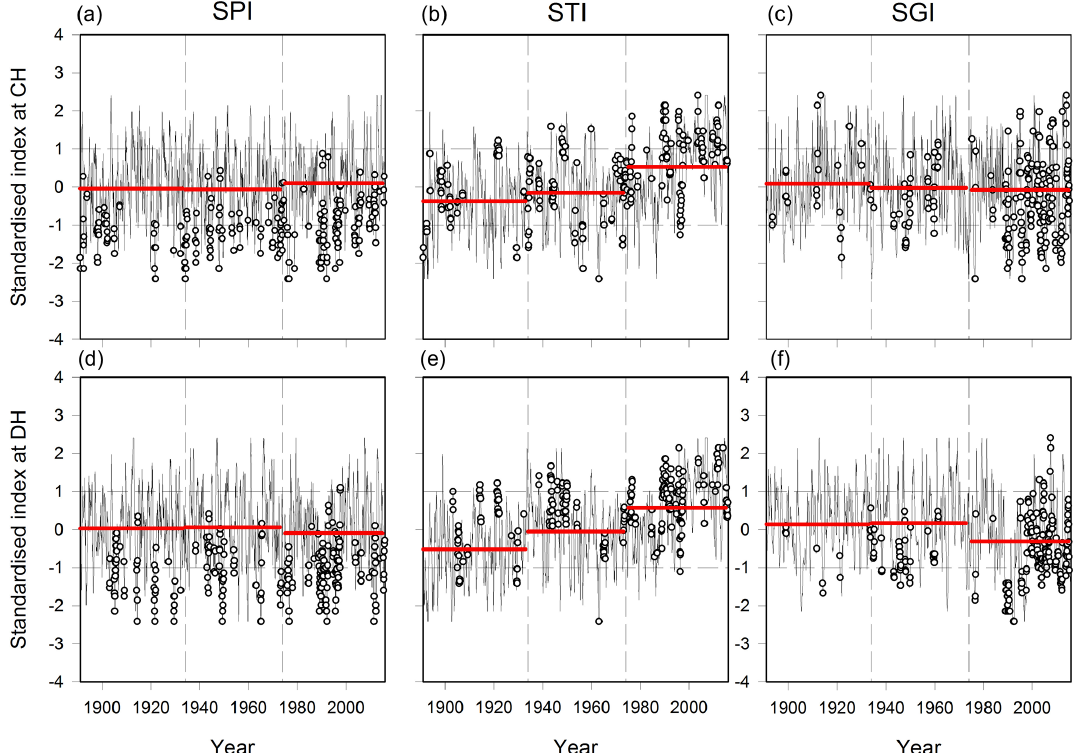
Figure 2. Changes in standardised indices of precipitation, temperature and groundwater level since 1891. Time series of SPI, STI and SGI for CH (a, b, c) and DH (d, e, f) for the period 1891–2015, with mean values for first, middle and last thirds of the record highlighted in red. Open circles in plots of SGI denote months where STI is ≥ 1, and in plots of SPI and STI denote months where SGI is ≤ − 1. Percentages are for months in the first and last third of the records where SGI and SPI are ≤ − 1 and STI is ≥